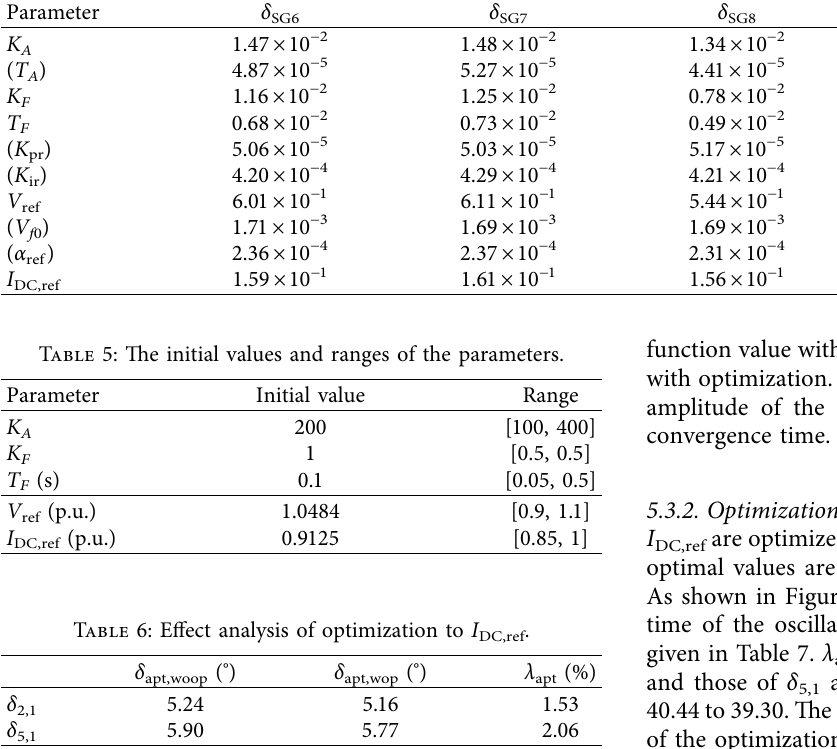
Table 4: Te TS indices for δ